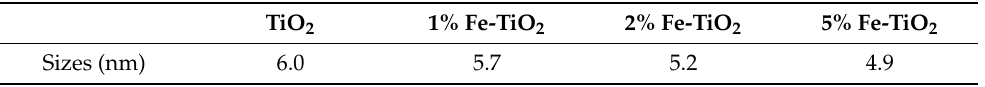
Table 1. Estimated crystallite sizes (nm) for TiO 2 , 1, 2, and 5% mol of Fe-TiO 2 nanoparticles with PEG synthesized by microwave irradiation .